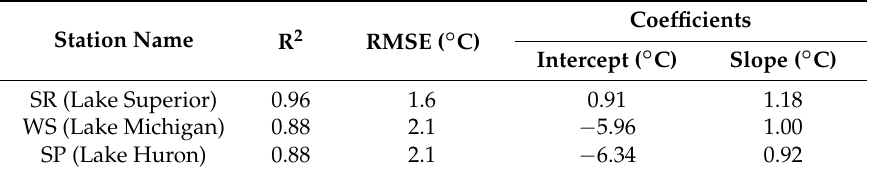
Table 2. Root Mean Square Error (RMSE) and R 2 between Modern-Era Retrospective analysis for Research and Applications (MERRA) air temperature and measured air temperature at a height of ~30 m above the water surface from in-situ measurements during 2014.